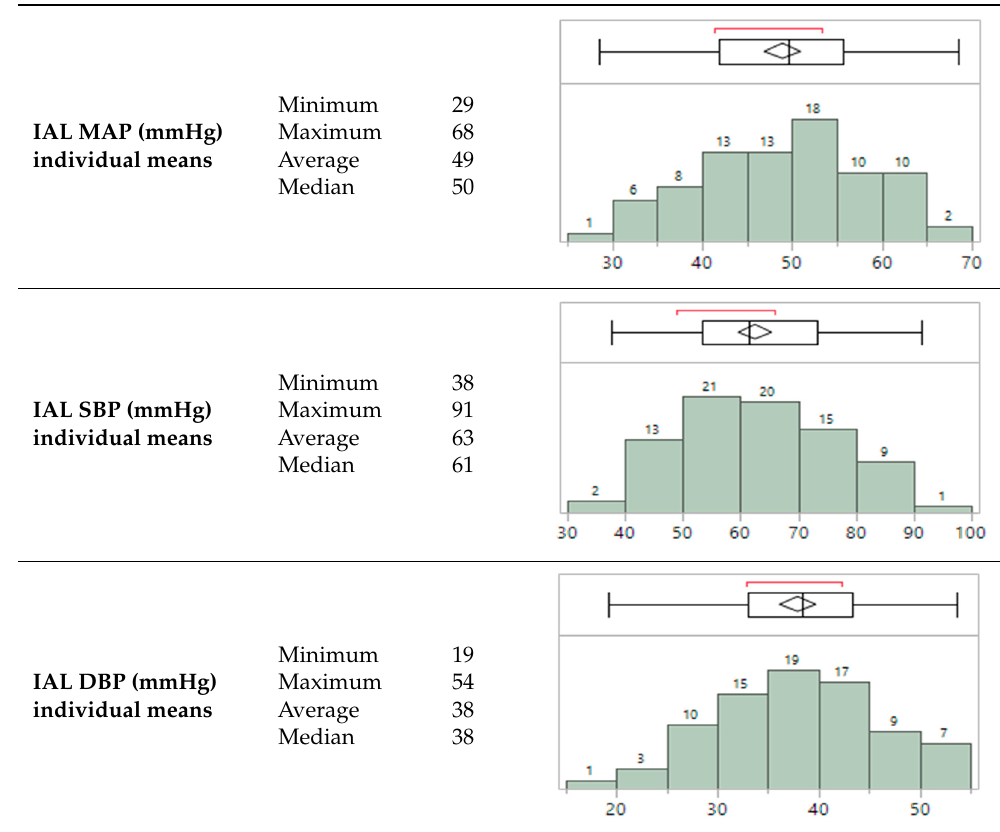
Table 4. Characteristics of the invasive arterial line data.